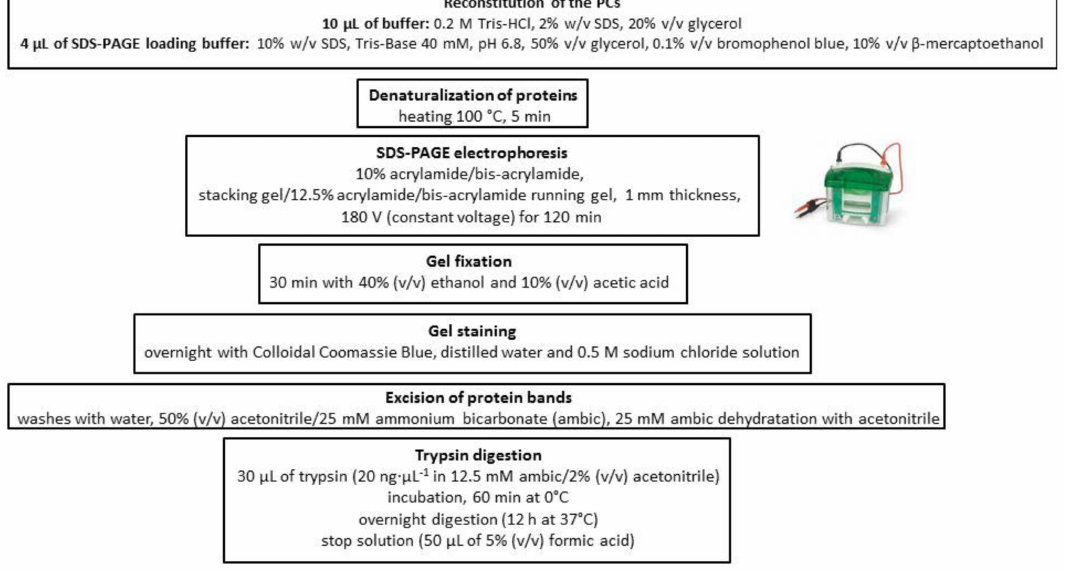
Figure 6. Flowchart depicting the separation and digestion of the corona proteins associated with